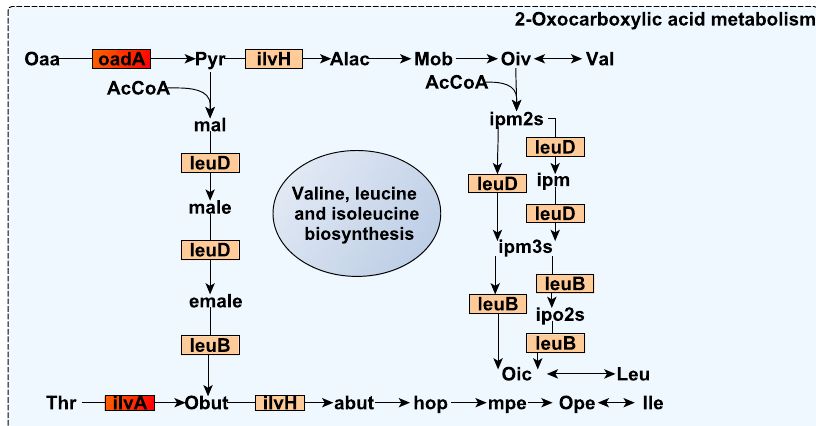
Fig. 3 Reaction scheme of 2-oxocarboxylic acid metabolism and branched-chain amino acid biosynthesis, in which additive log-ratio transformed microbial gene abundances strongly host genomically correlated with methane emissions ( r gCH4 ) are involved. Small rectangles symbolize proteins encoded by the microbial genes. Microbial genes are highlighted in red when their r gCH4 estimates range between − 0.74 and − 0.93 and show a probability of being different from 0 ( P 0 ) ≥ 0.95, and in orange when they range between |0.55| and |0.77| and P 0 ≥ 0.85. Source data is in Supplementary Data 9. Compounds are denoted by their short names. Full names of compounds and microbial genes are given in Supplementary Data 17.